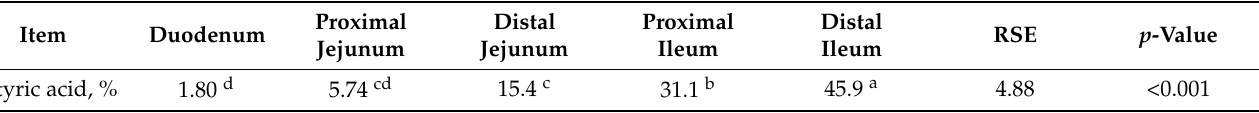
Table 1. Percentage of released butyric acid in the small intestine of broiler chickens supplemented with protected sodium